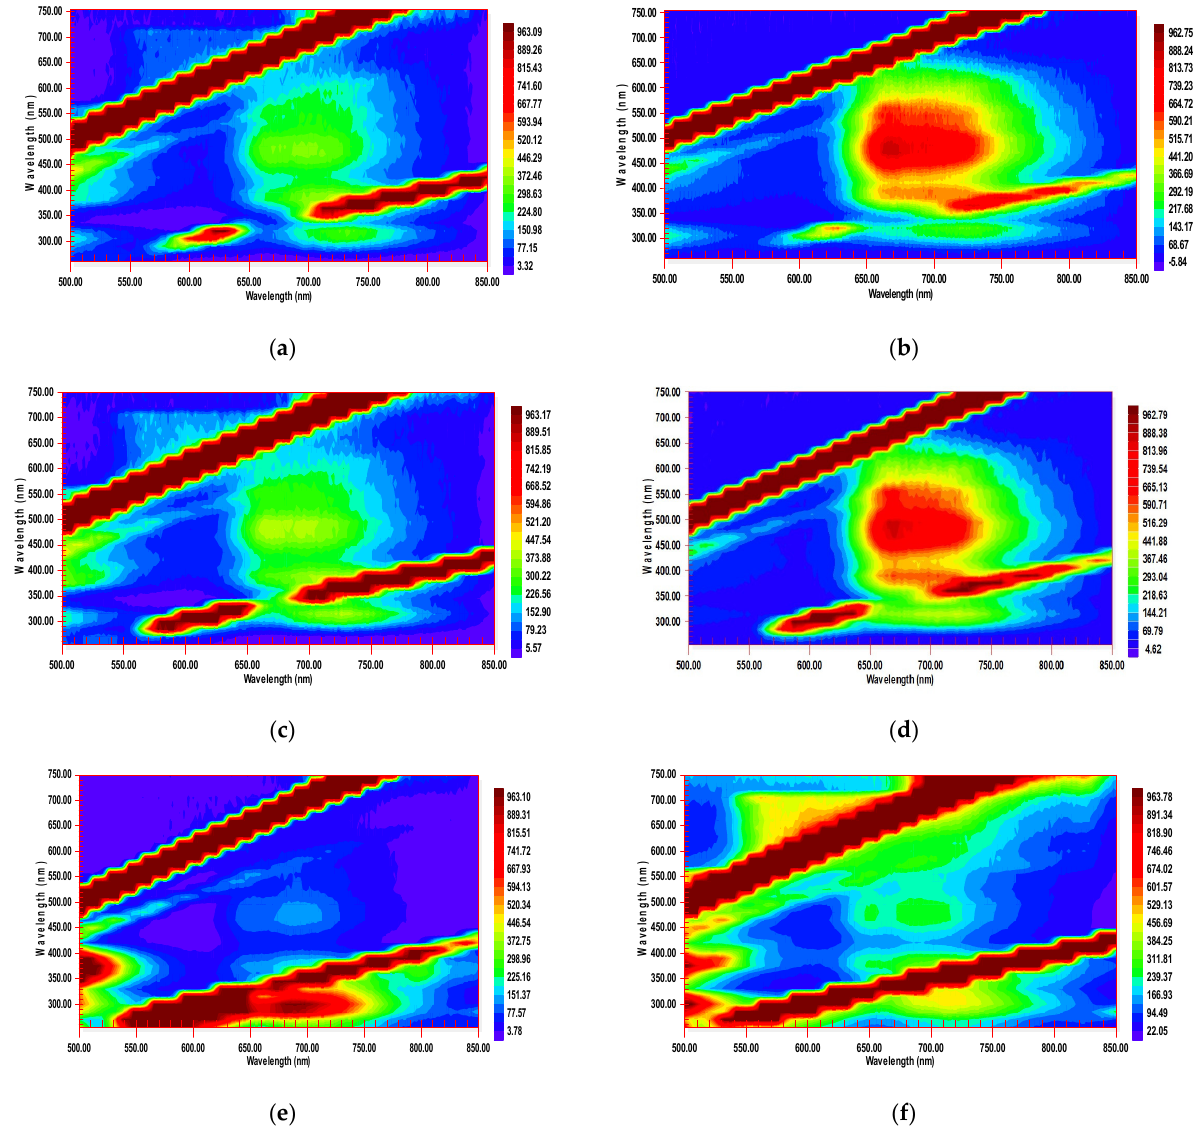
Figure 9. Excitation–emission maps of mixtures of C 60 and C 70 ( a ) technological and ( b ) model in benzene; ( c ) technological and ( d ) model in toluene; ( e ) technological and ( f ) 3:1 wt. model in n -hexane. The technological mixture is 67 µ M. In the model mixture, the concentration of C 60 is 50.0 µ M and of C 70 it is 16.3 µ M. Excitation/emission slits, 20/20 nm; detector voltage, 870 V; scanning pitch, 15 nm. Y -axis is excitation, X -axis is